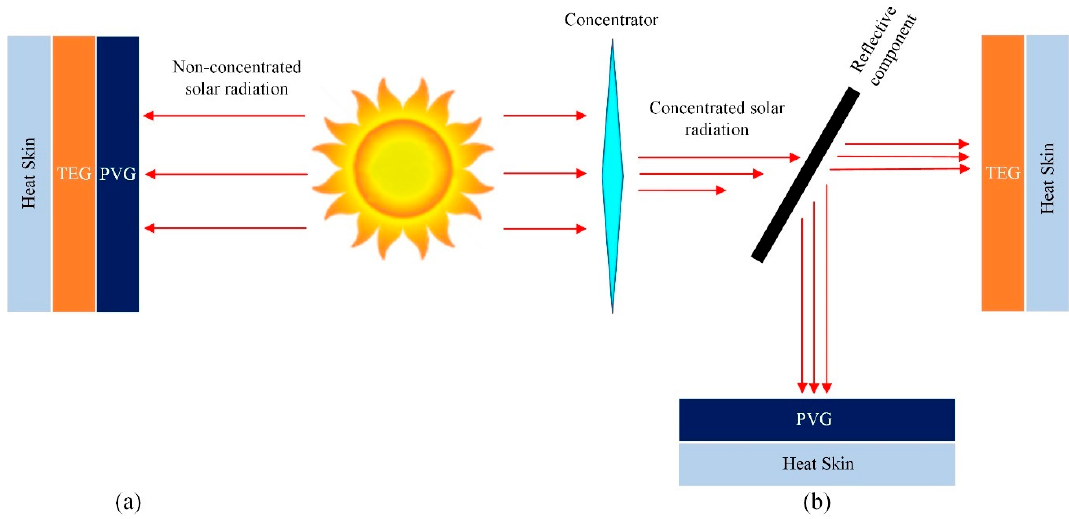
Figure 4. Generic scheme of current solar thermoelectric generators (STEGs) ( a ) without reflective component and ( b ) with reflective component.